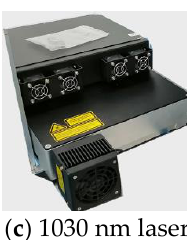
Figure 9. The circuit of photovoltaic panels. transmission of 8.7 m. The divergence angle of the 1030 nm laser is the smallest with only 1.43 mrad, its light intensity is a typical Gaussian distribution, and the light uniformity is the worst, followed by the 532 nm laser. gradually decreases.